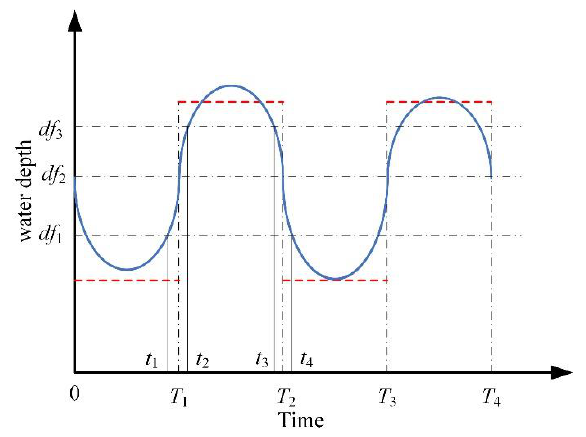
Figure 2. The variation in water depth influenced by tides. (Source: compiled by the